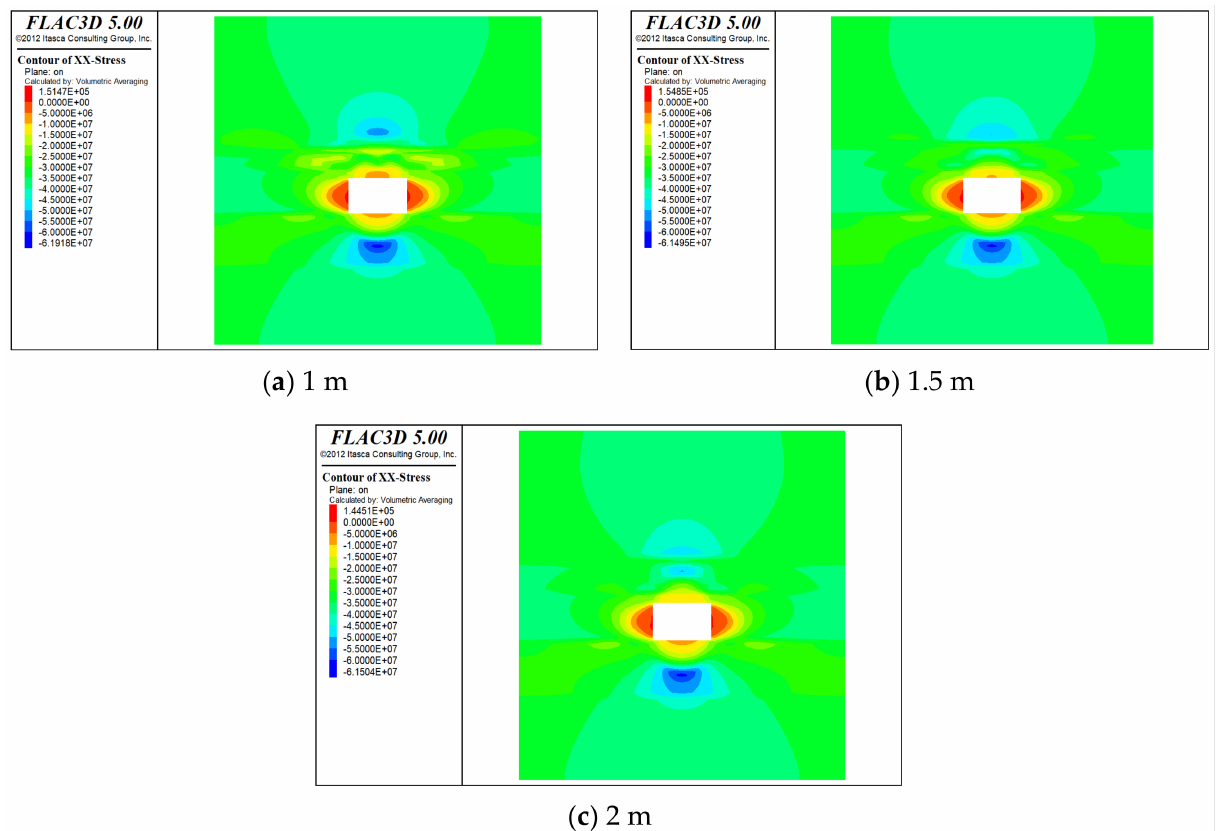
Figure 7. Horizontal stress distribution diagrams of roadway surrounding rock. Note: “ − ” for positive compressive stress; “+” for tensile